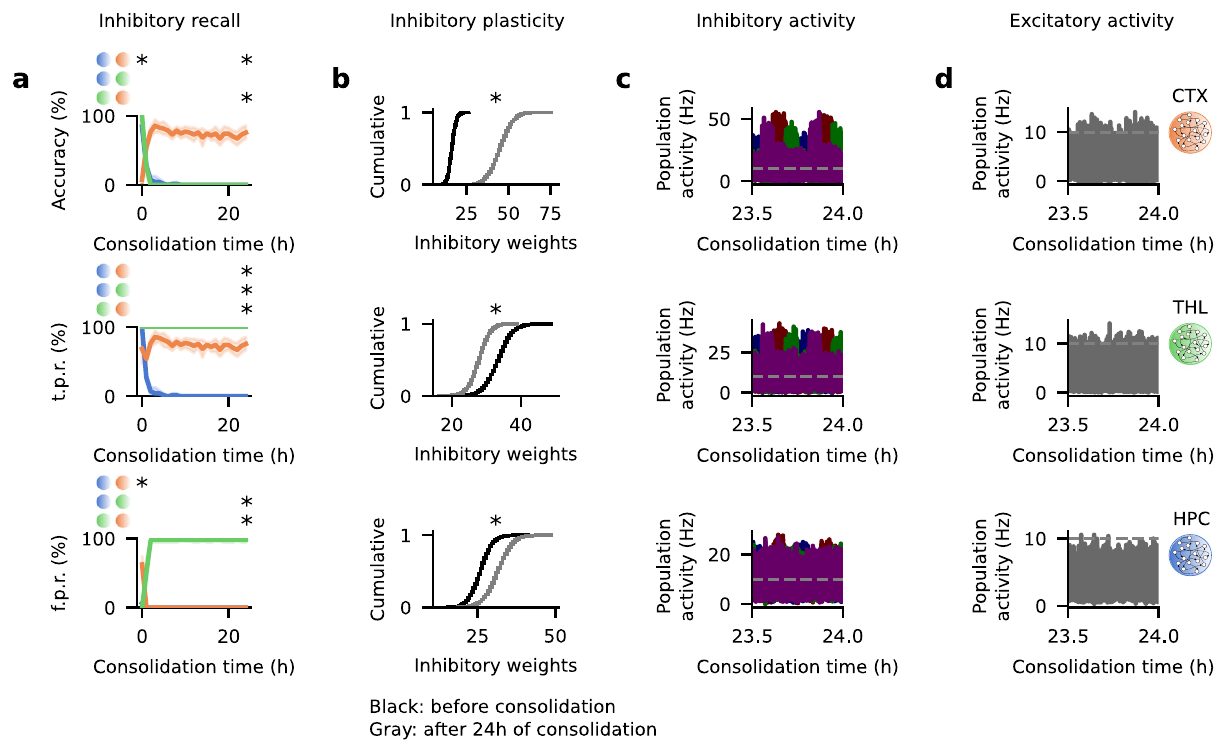
Fig. 3 Dynamics of inhibitory engram cells are region-speci fi c. a – d Analysis of engram dynamics in Fig. 2b. a Recall of inhibitory engram cells in HPC, THL, and CTX during the testing phase as a function of consolidation time. Top to bottom: accuracy, true positive rate, and false positive rate. Color as in Fig. 2a. n = 5 trials. Mean values and 90% con fi dence intervals shown. For each recall metric, two-sided Mann – Whitney U test. Accuracy: consolidation time = 0 (HPC vs. CTX p -value = 1.166731 × 10 − 2 ; HPC vs. THL p -value = 7.491290 × 10 − 2 ; THL vs. CTX p -value = 8.968602× 10 − 2 ) and 24 h (HPC